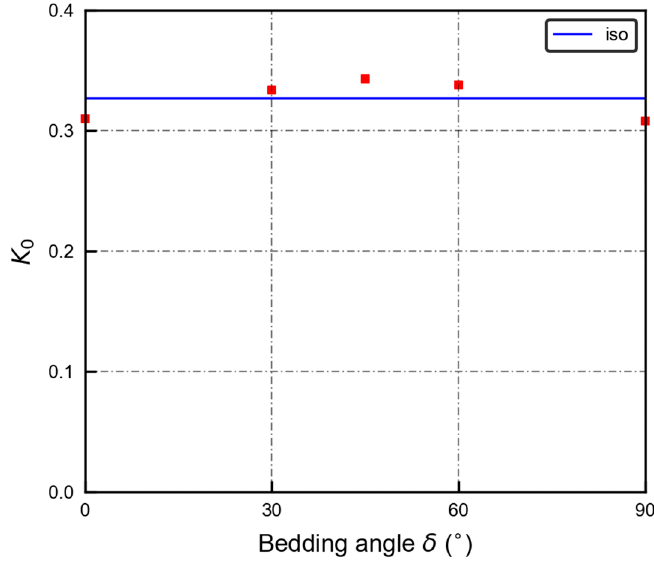
Figure 7. Evolutions of ( a ) K 0 and ( b ) K (cid:48)